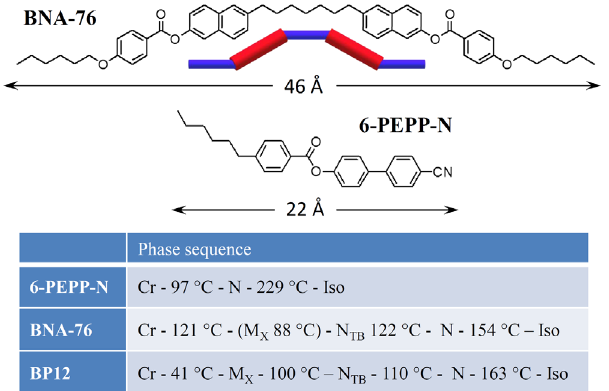
FIG. 1. Molecular structure and phase sequence of the LC compounds. For the BNA-76 bent-shaped dimer, a simplified sketch of the average conformation of the molecule is also shown, with the electron-rich conjugated parts in red and the alkyl and alkoxy chains in